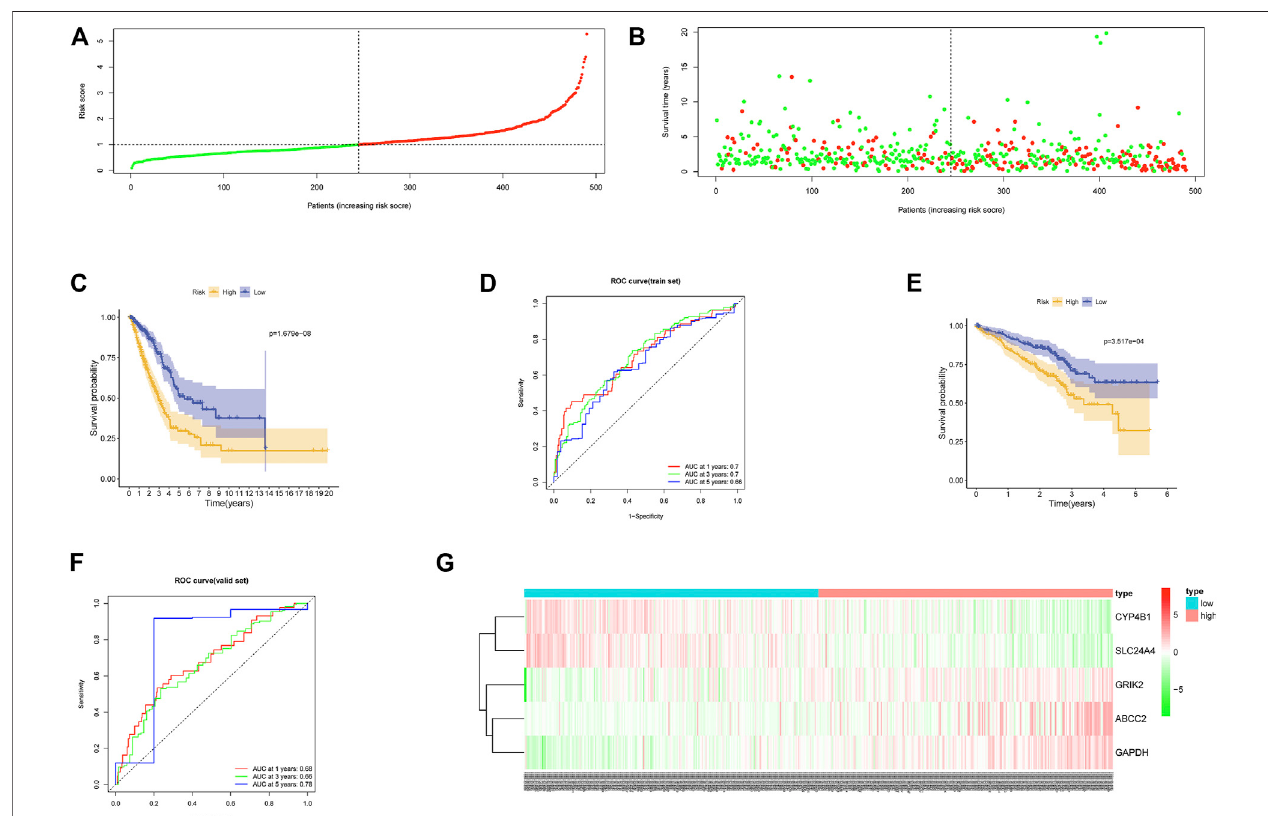
FIGURE 3 | Performance of the prognostic model. (A) Distribution of risk score of each LUAD sample in the training set (green: patients having low-risk score; red: patientshavinghigh-riskscore). (B) ScatterdiagramofsurvivalstatusofLUADpatientsaccordingtoriskscore(green:survivedpatients;red:deadpatients). (C) Survival curves of high- and low-risk groups in the training set. (D) ROC curves of the prognostic model in the training set. (E) Survival curves of the high- and low-risk groups in the validation set. (F) ROC curves of the prognostic model in the validation set. (G) Heat map of the expression of the fi ve feature genes in the high- and low-risk groups in the training